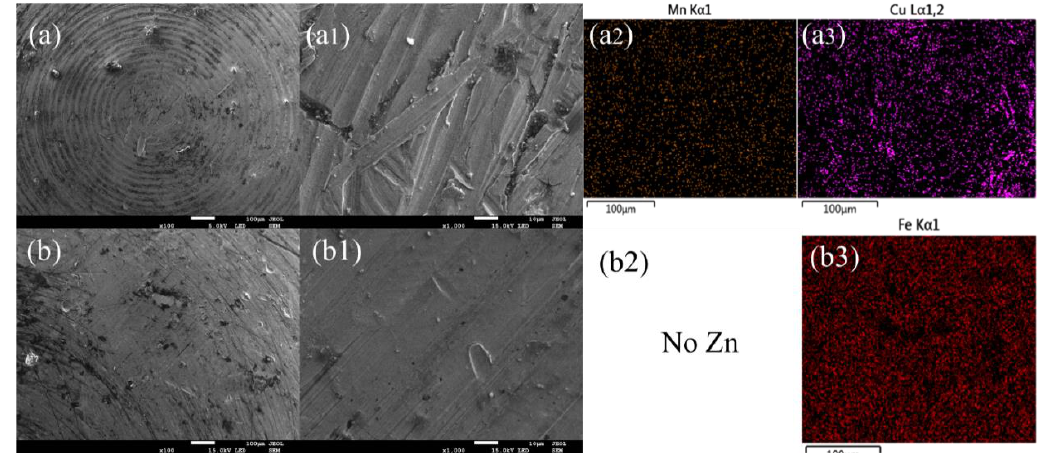
Figure 10. Elemental mapping of Mn, Cu, Fe, Zn on the worn surfaces of counterfaces. ( a , b , a1 , b1 ) Morphology and atomic distribution of grinding ball. ( a2 ) Enlarged view of the surface of manganese containing material. ( a3 ) Enlarged view of copper containing material surface. ( b2 ) Enlarged view of zinc free material surface. ( b3 ) Enlarged view of ferrous material